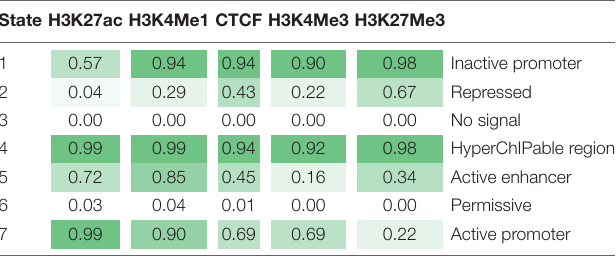
TABLE 4 | Emission probabilities for seven states from